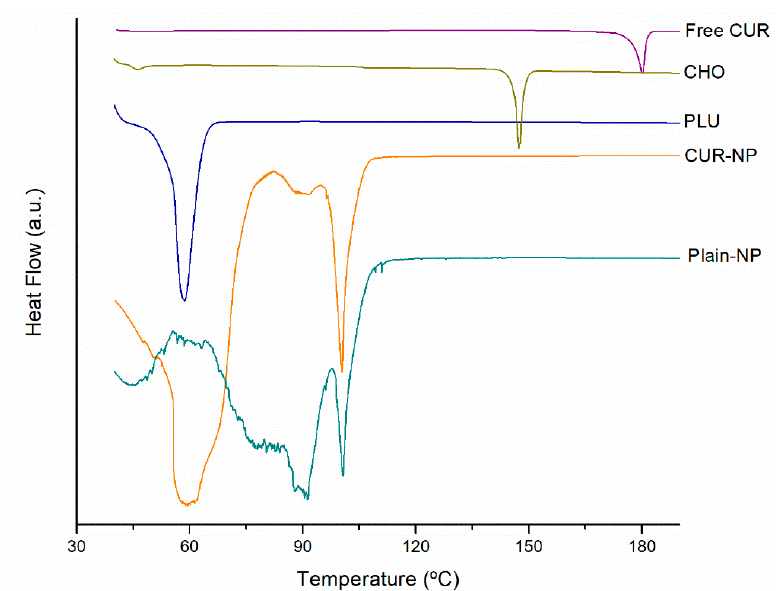
Figure 3. DSC curves of PLHN main components and the CUR loaded formulation.